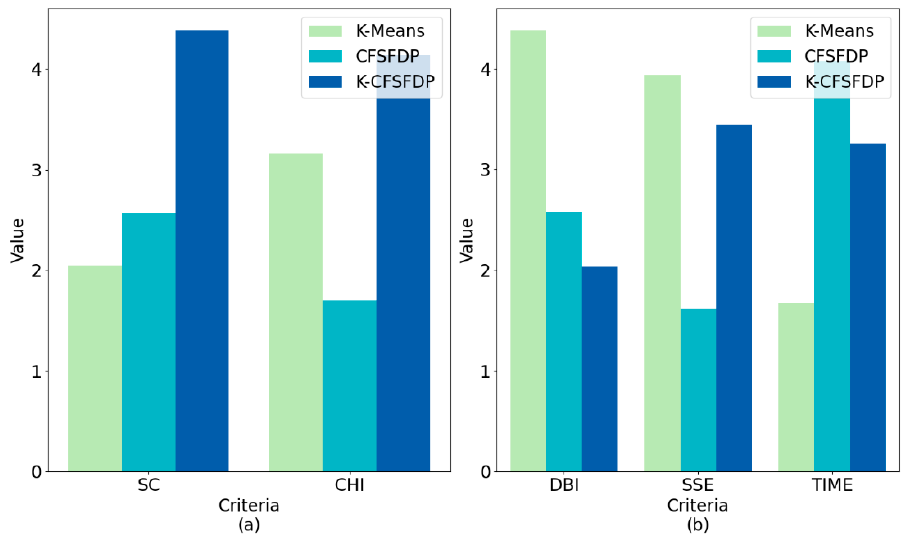
Figure 19. Clustering performances of three models under different evaluation criteria in dataset S4: ( a ) the higher the value, the better and ( b ) the lower the value, the better.